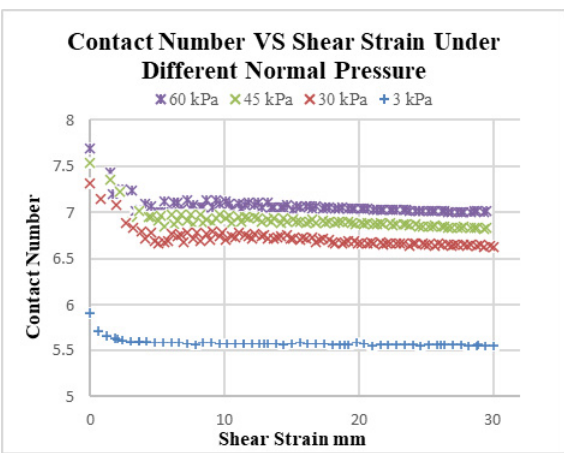
Figure 10 Variations of CN versus shear strain for various normal stresses (SI 150%)